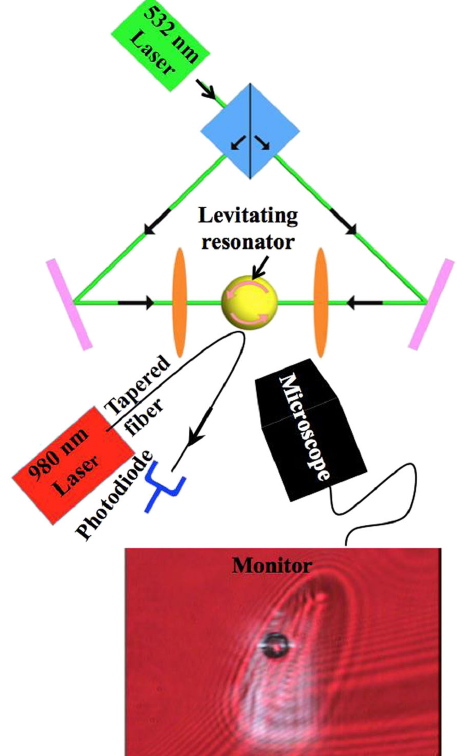
FIG. 2. Experimental setup for phase-matched coupling to a contactless sphere. A counterpropagating optical tweezer traps a silicone oil droplet. At the same time, a tapered-fiber coupler is brought nearby to the droplet. The transmission through the droplet resonator is monitored throughout the other side of the taper. The experiment is performed under the microscope while a monitor shows a micrograph of the droplet in which the bent tapered fiber is seen at the background, out of focus. The refractive index is 1.4 and the wavelength is 980